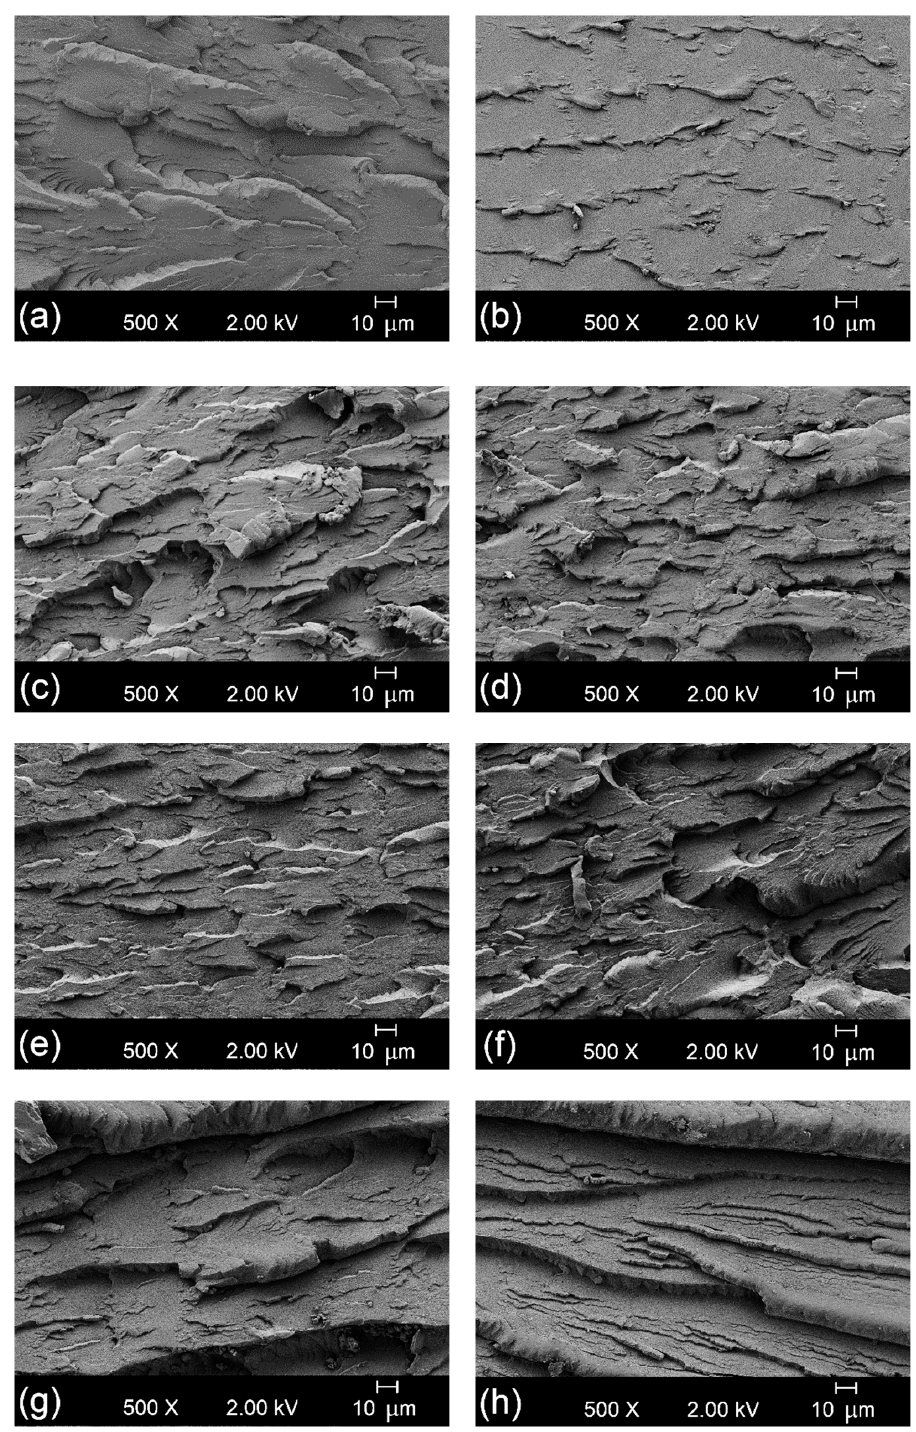
Figure 3. Field emission scanning electron microscopy (FESEM) images, taken at 500 × , corresponding to fracture surfaces of the injection-molded pieces of the partially bio-based and recycled polyethylene terephthalate (bio-PET / r-PET) blends: ( a ) B100; ( b ) R100; ( c ) B85-R15; ( d ) B70-R30; ( e ) B55-R45; ( f ) B55-R45-X1; ( g ) B55-R45-X3; ( h ) B55-R45-X5. Scale markers of 10 µ